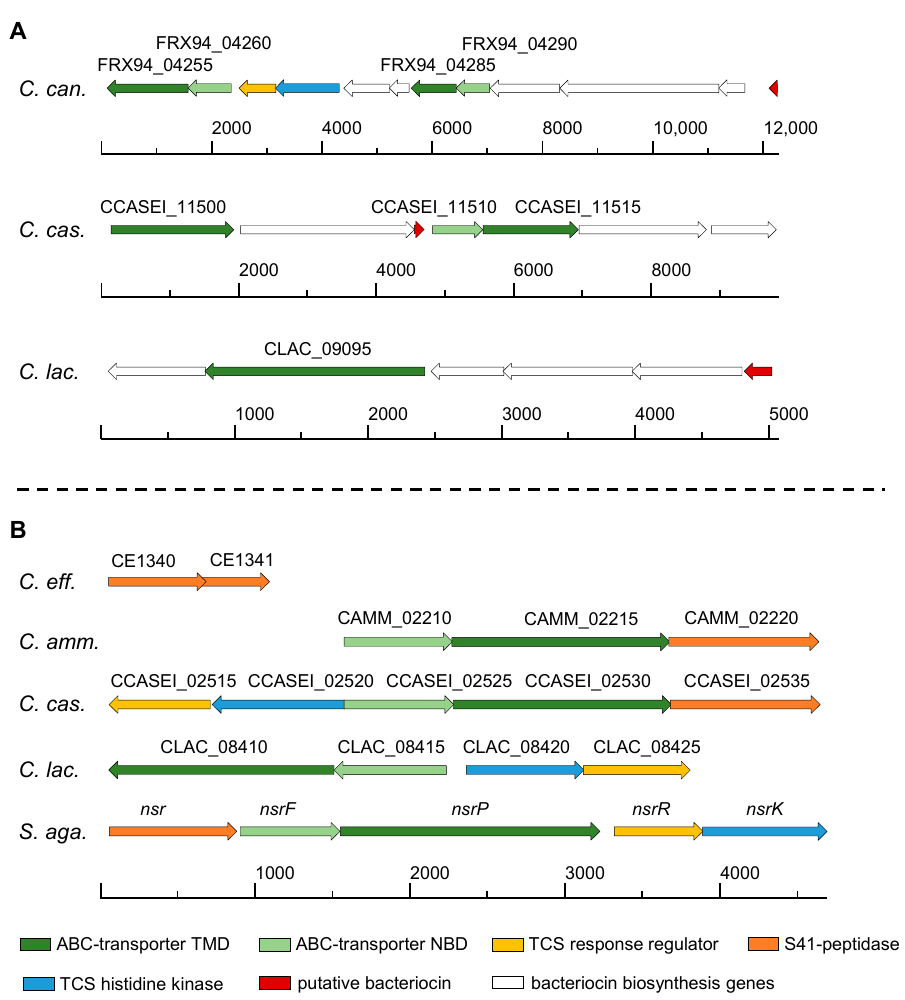
Figure 5. Putative BGCs ( A ) and lantibiotic resistance loci ( B ) in C. canis (= C. can .), C. casei (= C. cas .), C. lactis (= C. lac .), C. efficiens (= C. eff .), C. ammoniagenes (= C. amm. ), S. agalactiae (= S. aga .). The S. agalactiae nsr -operon is shown for comparison. Scale bar and numbers indicate base-pair lengths. Locus tags are displayed above the respective genes.